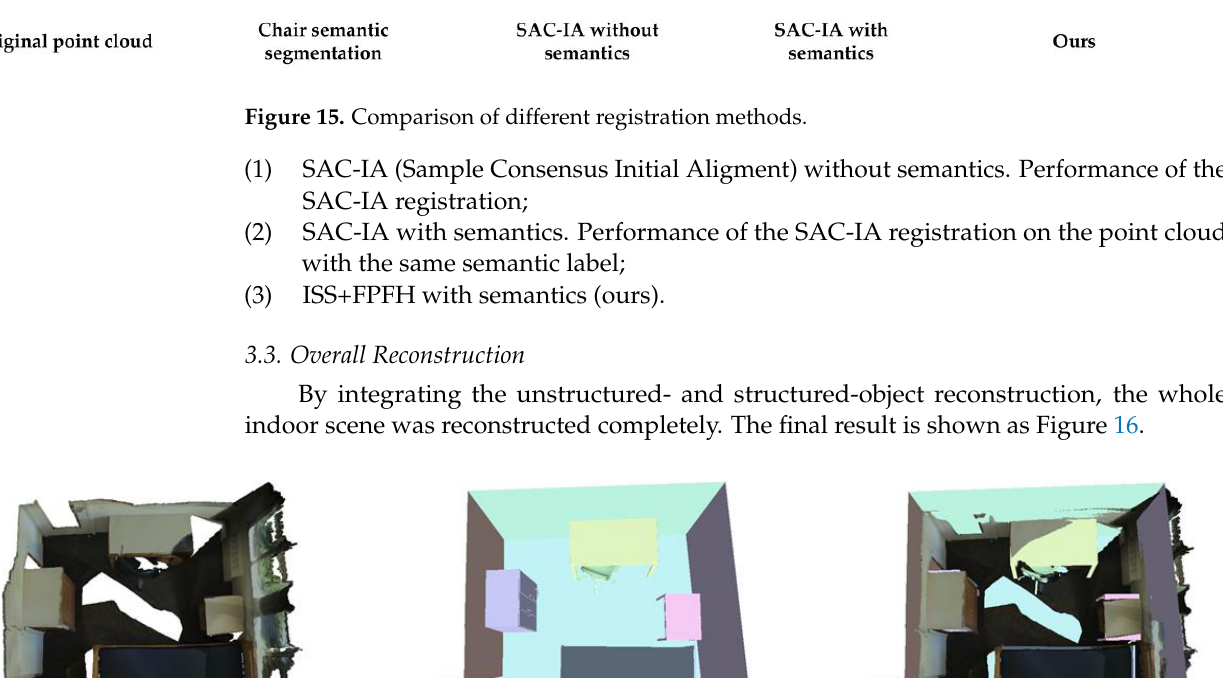
Figure 16. Overall reconstruction: ( left ) the original input point cloud, ( middle ) the reconstruction result, ( right ) the overlay of ( left ) and ( middle ).